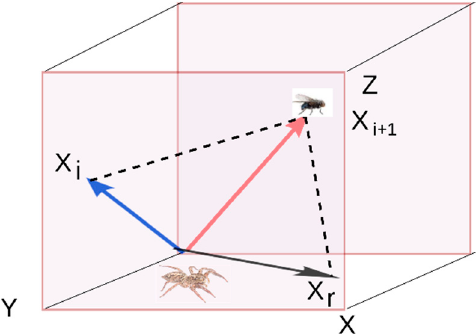
Figure 3. Representation of Jumping Spider’s persecution strategy.